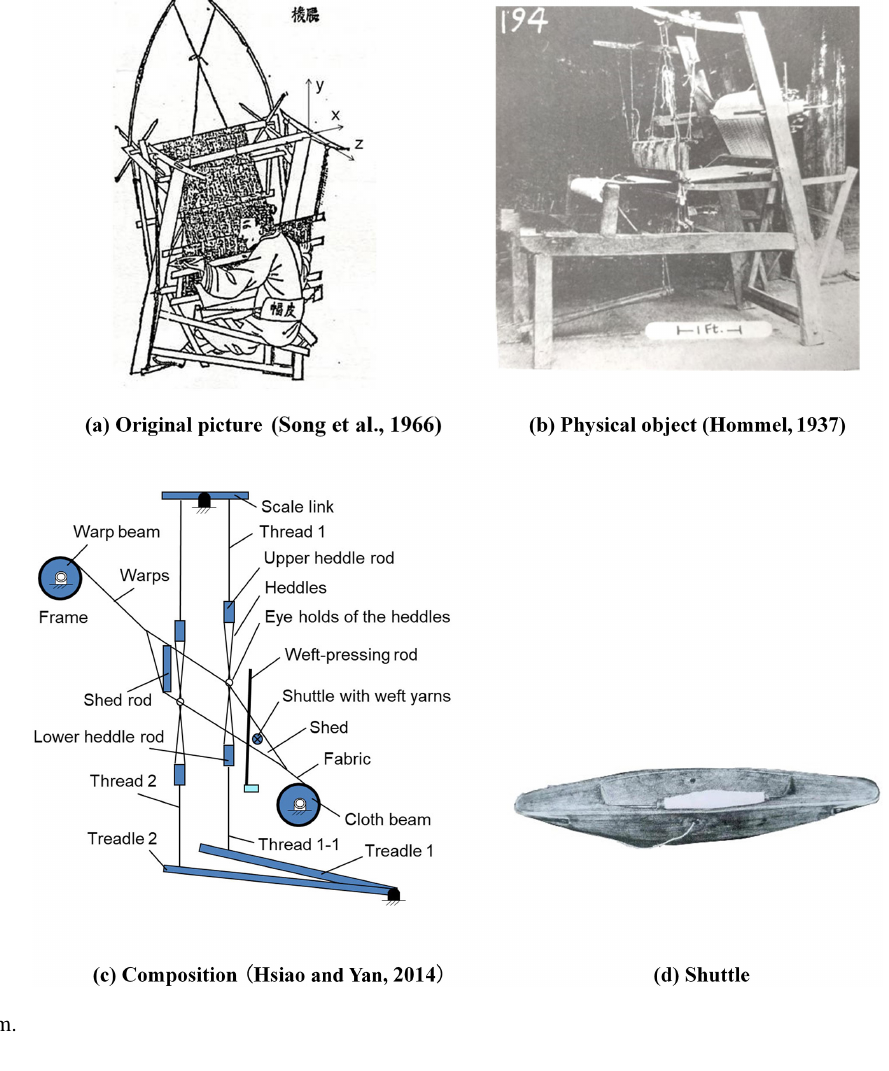
Figure 8. The loom.